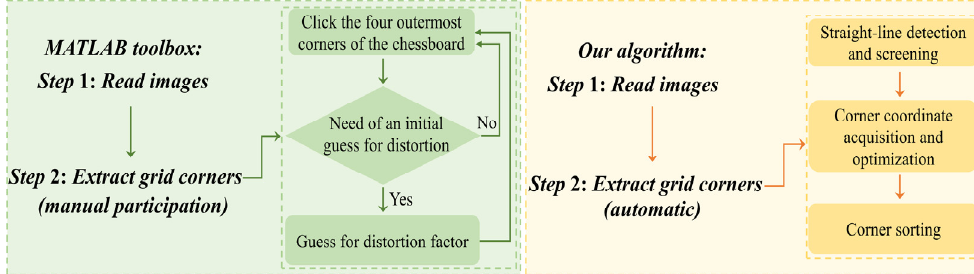
Figure 10. The flow chart comparison between our algorithm and MATLAB